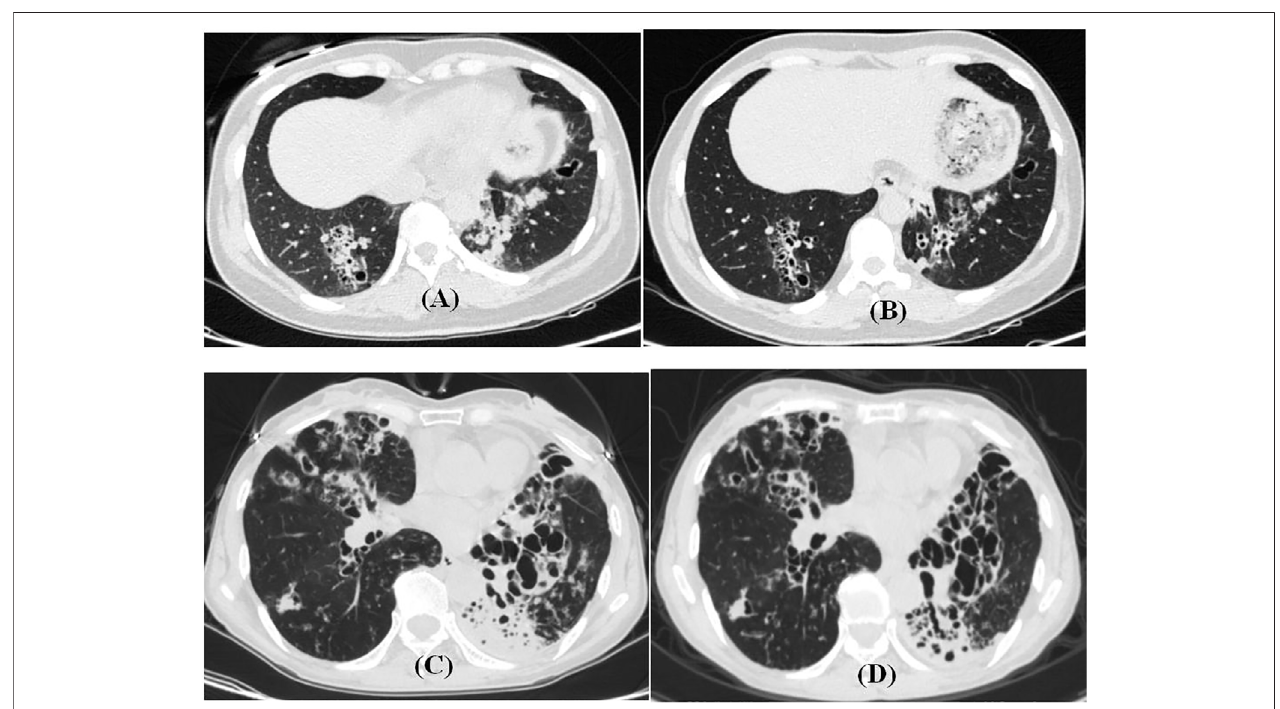
FIGURE 3 | HRCT features before and after endobronchial therapy with non-CF bronchiectasis. (A,B) 42-year-old female patient with airway drugs. Cough and expectoration repeatedly for 4 years. (A) HRCT during exacerbation. (B) HRCT 5 months later. (C,D) 63-year-old female patient in the drug group. Cough and expectoration repeatedly for 40 years. (C) , HRCT during exacerbation. (D) HRCT 4 months later.